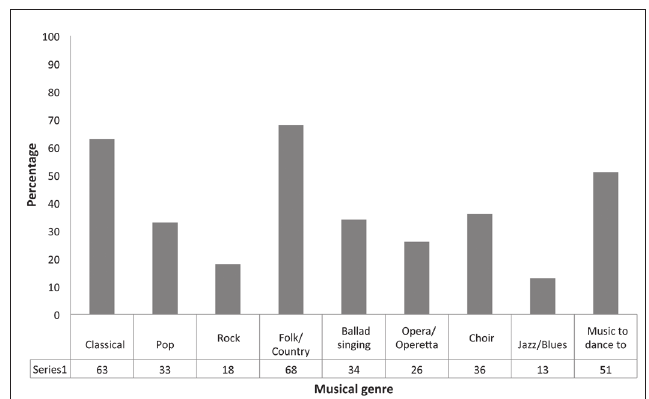
Fig. 1. Participants’ musical genre preferences.